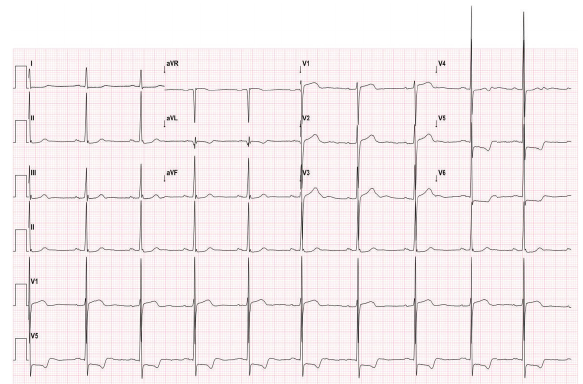
Figure 1: Electrocardiography. Baseline electrocardiogram showing left ventricular hypertrophy and ST-T changes in precordial leads 4–6.